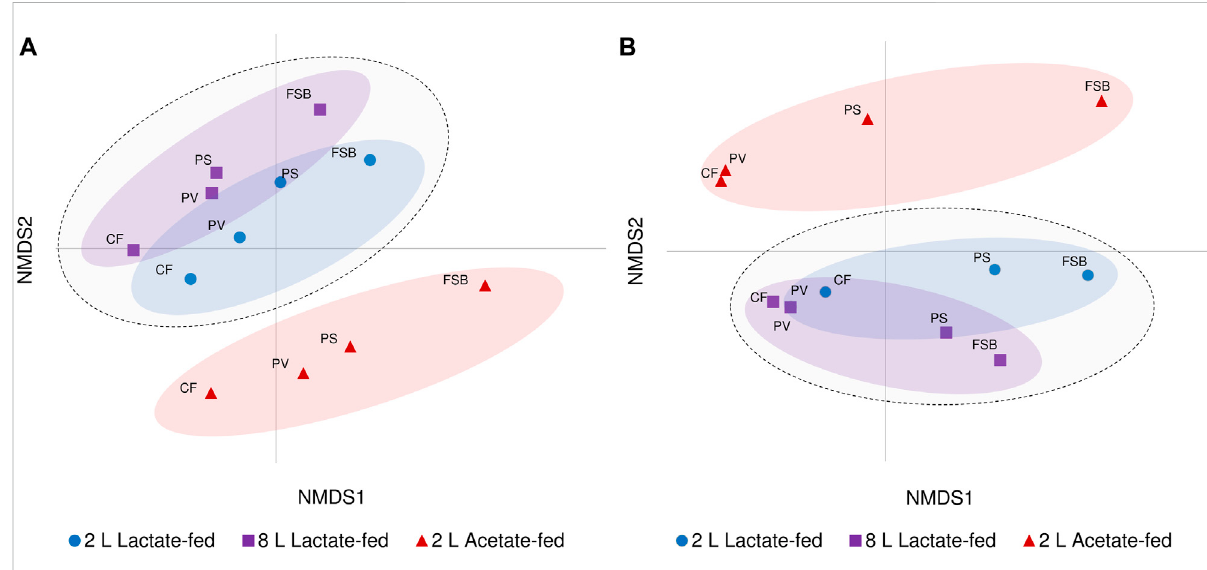
FIGURE 6 Non-metric multidimensional scaling (NMDS) ordination plot visualisation of beta diversity showing differences in microbial communities (CF, PV, PS, and FSB) in the 2 L lactate-fed, 8 L lactate-fed, and 2 L acetate-fed reactors at (A) 30 ° C and (B) 10 °